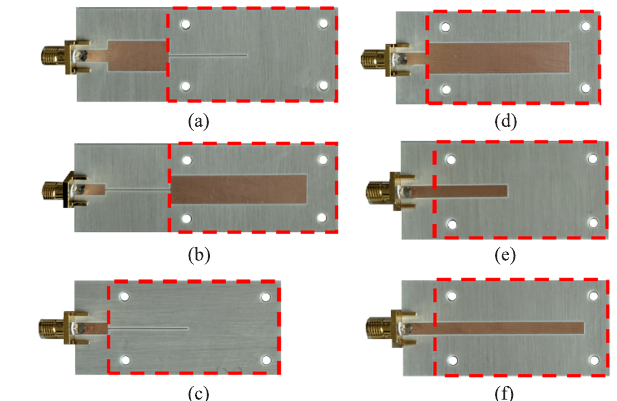
Figure 30. Schematic of the phase-variation sensor based on a sensing line and a step-impedance transmission line (with quarter-wavelength line sections). ( a ) Sensor with step-impedance discontinu- ity where Z < Z 0 < Z s . ( b ) Sensor with step-impedance discontinuity where Z > Z 0 > Z s . ( c ) Sensor with uniform mismatched sensing line where Z s > Z 0 . ( d ) Sensor with uniform mismatched sensing line where Z s < Z 0 . ( e ) Sensor based on a 90 ◦ uniform 50- Ω sensing line. ( f ) Sensor based on a 180 ◦ uniform 50- Ω sensing line. Reprinted with permission from Ref.